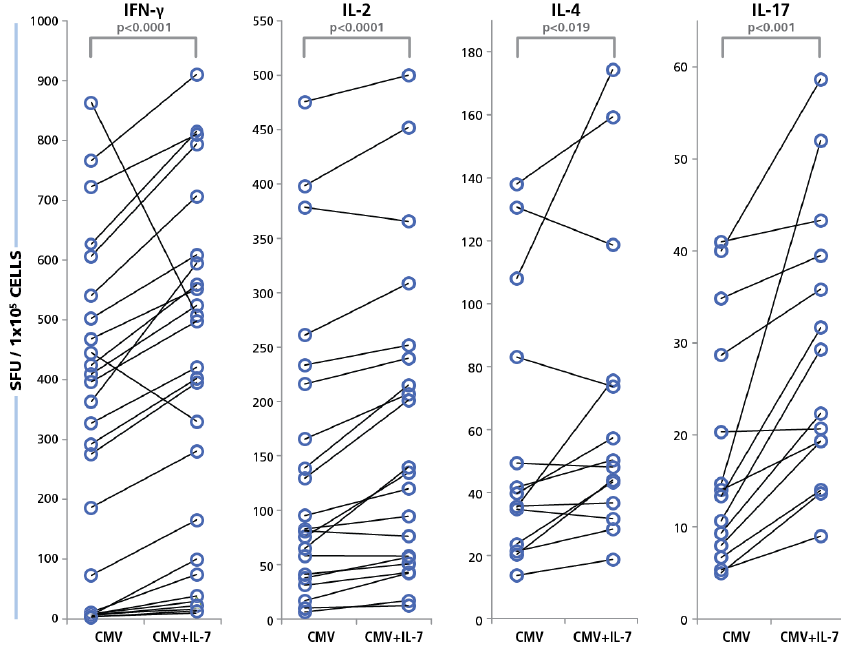
Figure 10. Restoration of functionality of exhausted CD4 cells with IL-7. PBMC from